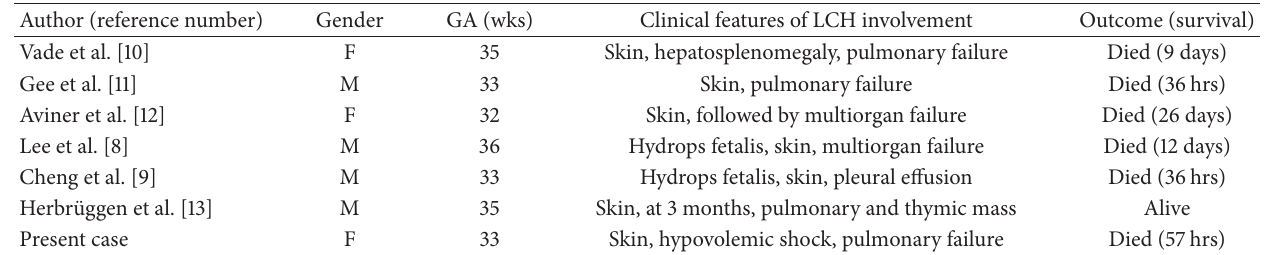
Table 1: Outcomes of premature neonates with congenital cutaneous LCH lesions at